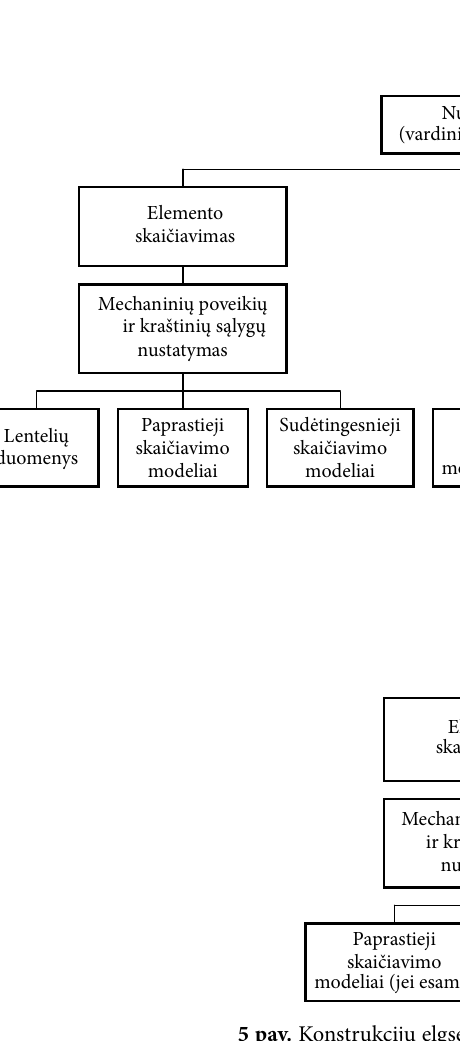
Fig. 5. Methods for calculating structural behaviour in